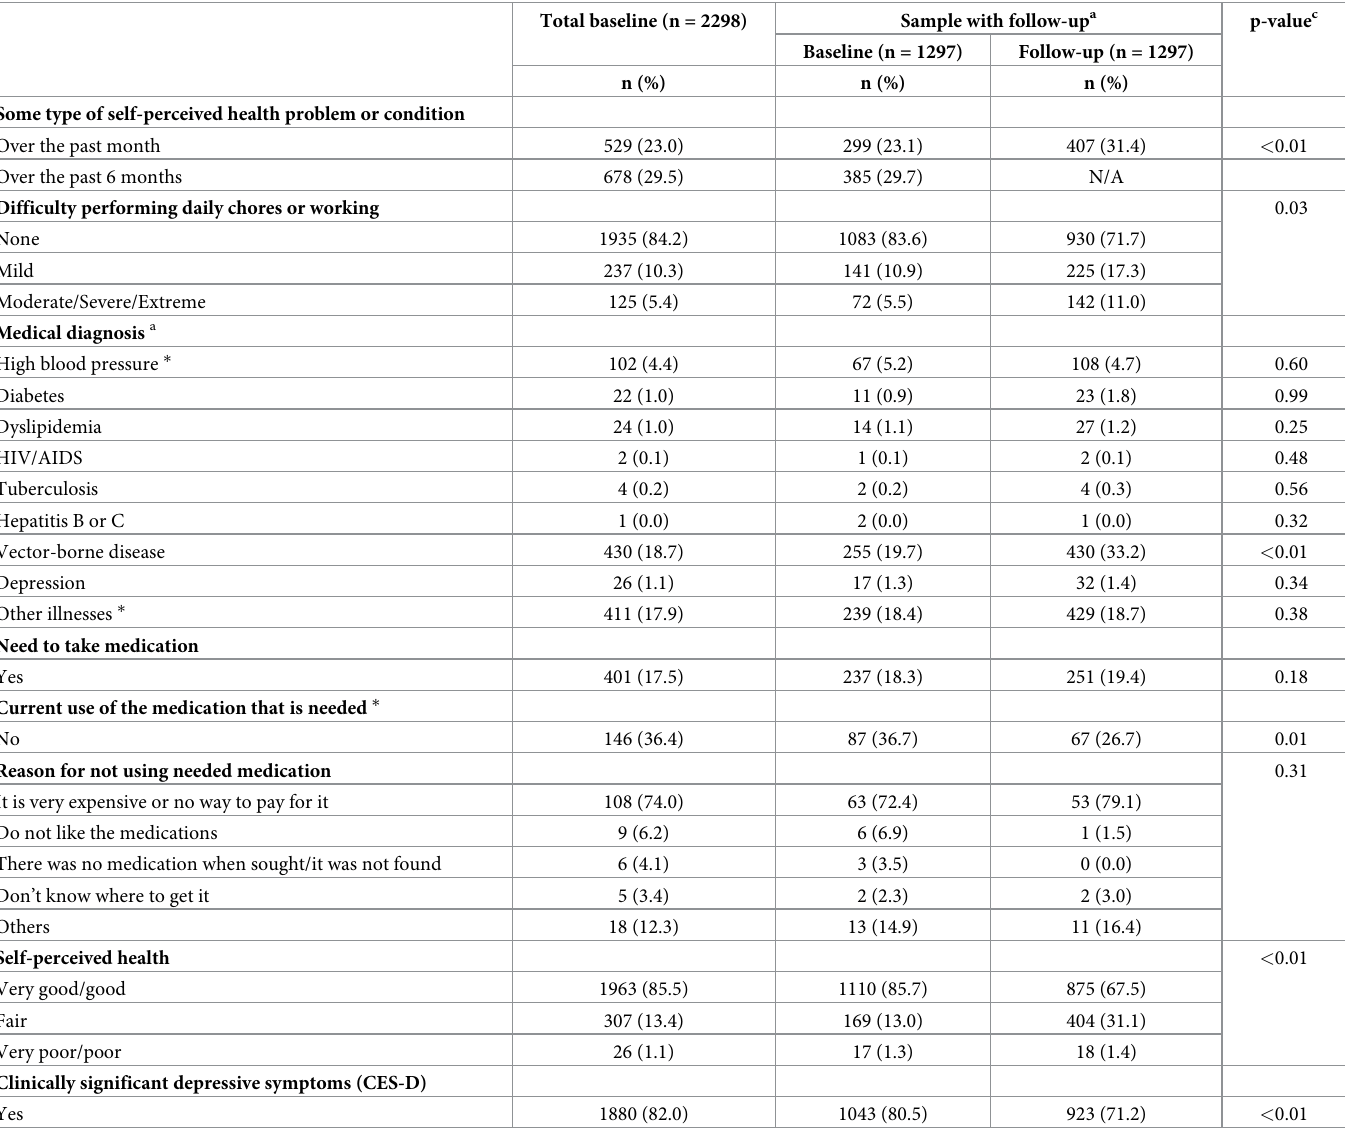
Table 2. Health status, access to healthcare services and self-perceived health among the migrant women with an irregular migration status participating in ELSA-- VENCOL,